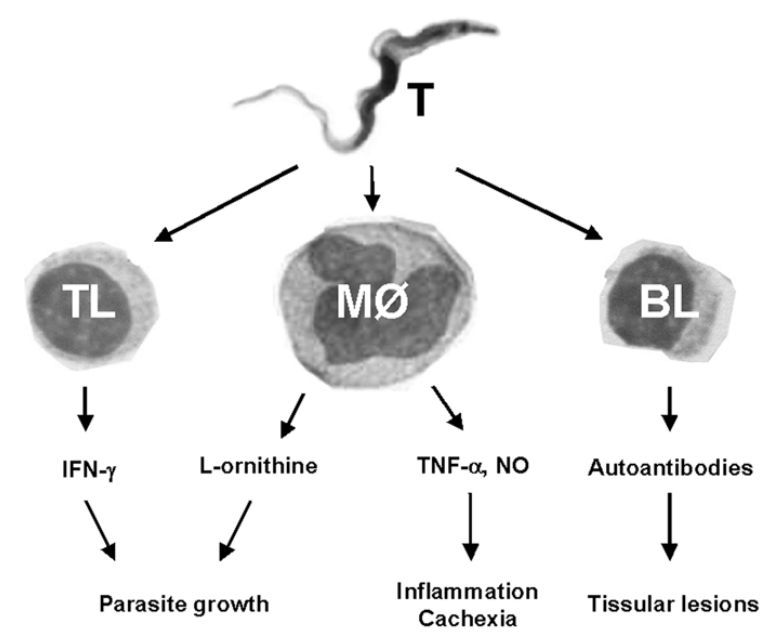
Fig. 2 – Trypanosomes induce secretion of various components from immune cells. Besides their trypanocidal effects, these molecules are also involved in deleterious mech- anismsforhosttissuesand/orfavourparasitegrowth. (T:trypanosome; Mø: macrophage; TL: T lymphocyte; BL: B